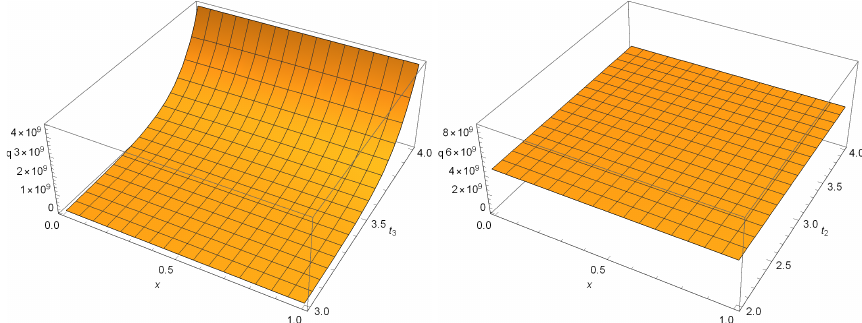
Figure 4. The graphs of the function of H ( t 1 , t 2 , t 3 ) , for the t 1 = 1, t 2 = 3 ( left ) and t 1 = 1, t 3 = 4 ( right